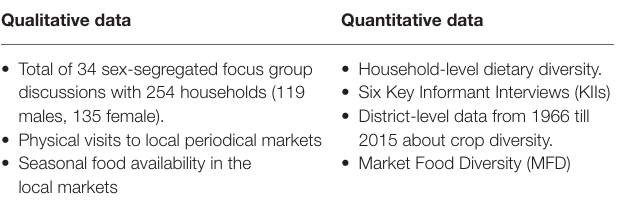
TABLE 2 | Sources of data. Qualitative data Quantitative